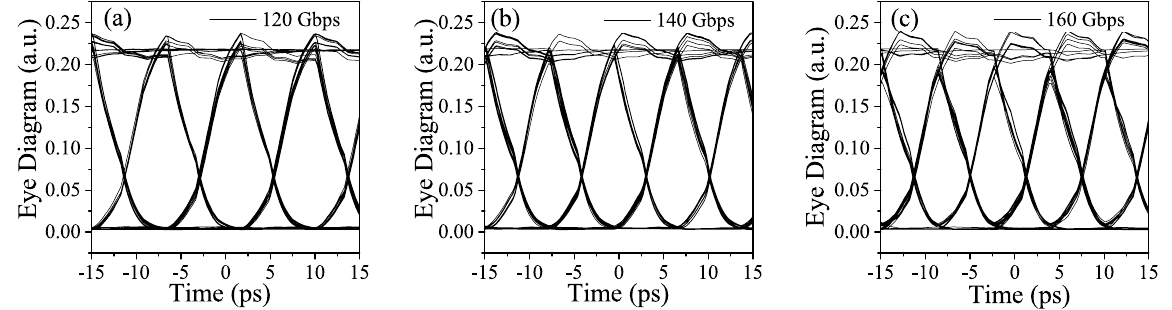
Figure 6. Eye diagrams of the 2 23 -1 PRBS modulation output. The modulation rates are ( a ) 120 Gbps, ( b ) 140 Gbps and ( c ) 160 Gbps,